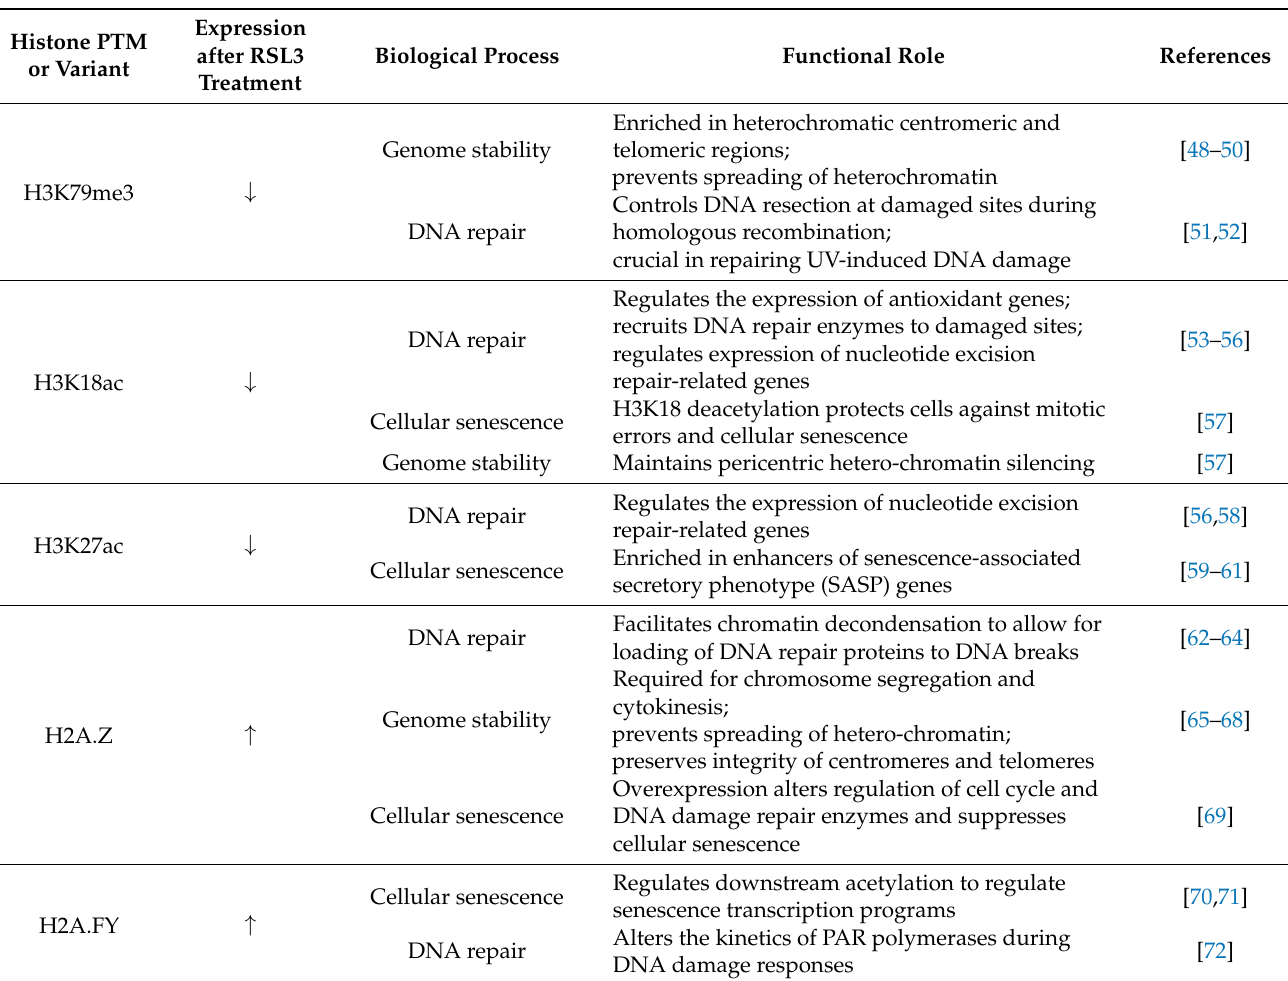
Table 1. Overview of RSL3-induced changes in histone PTMs linked to DNA repair and cellular senescence. Histone